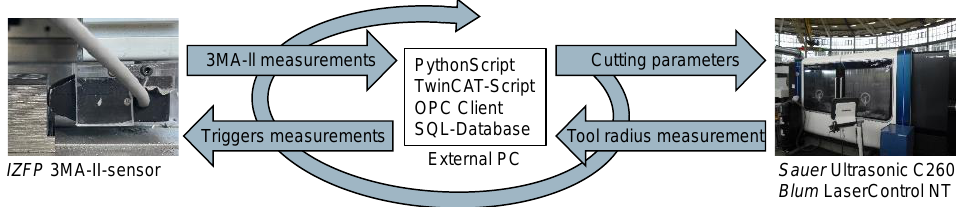
Figure 1. Dataflow of the developed data-driven surface layer property prediction setup.